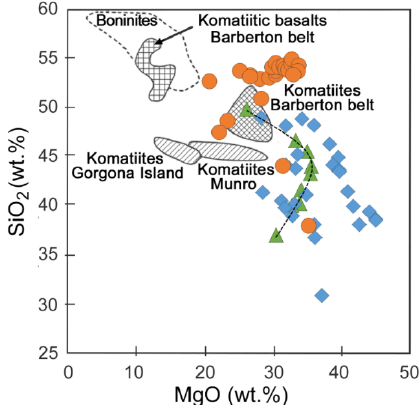
Figure 14. Plot of bulk-rock contents of MgO vs. SiO 2 (wt.%) showing compositional variations of the Lyavaraka complex (orange symbol; this study) compared with the compositional field of the Chapesvara complex [12] (blue symbol) and with the linear trend reported for the differentiated flow of the Mount Khanlauta complex [13] (green symbol). Additionally, shown for comparison are schematic boundaries of typical fields of boninites, komatiitic basalts and komatiites of the Barberton Belt in South Africa, Gorgona Island in Columbia, and the Munro area in Ontario, Canada, after